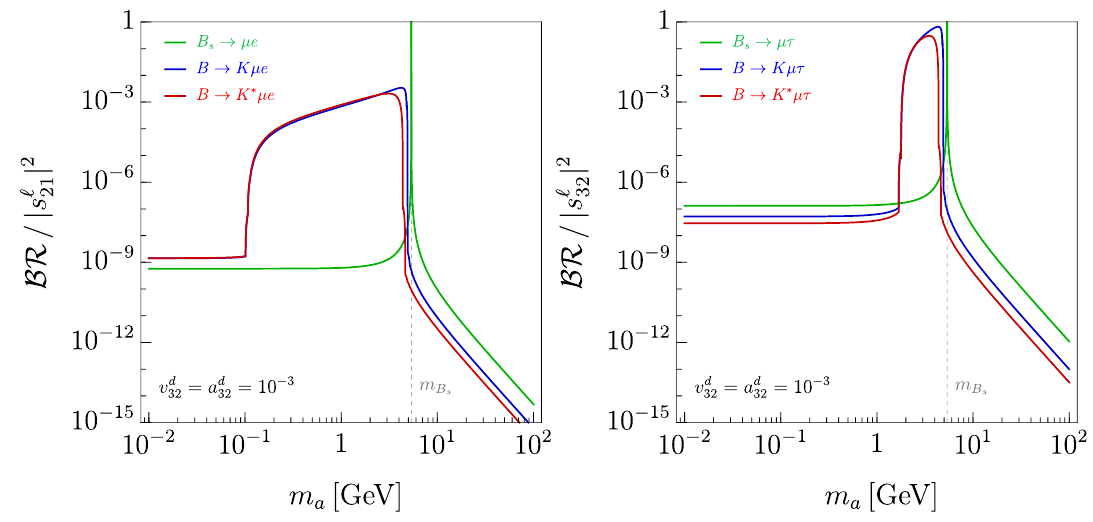
2 (green line), 2 (blue line) and Figure 12 . ( B K‘ i ‘ j ) = s ‘ ( B K (cid:3) ‘ i ‘ j ) = s ‘ ij j ij j B ! j B ! j 2 (red line) are plotted against m ‘ i ‘ j ) = s ‘ a for ( i; j ) = (1 ; 2) (left panel) and (2 ; 3) (right panel). ij j j The ALP couplings to quarks are taken to be v d = a d = 10 (cid:0) 3 , while the ALP width is (cid:12)xed to 32 32 (cid:0) a = 10 (cid:0) 6 GeV for illustration.